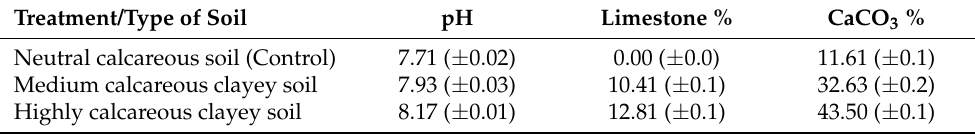
Table 2. Soil analysis for the three types of soil chosen: pH, limestone %, and Ca 2 CO 3 %. Treatment/Type of Soil pH Limestone % CaCO 3 % Neutral calcareous soil (Control) 7.71 ( ± 0.02) Medium calcareous clayey soil Highly calcareous clayey